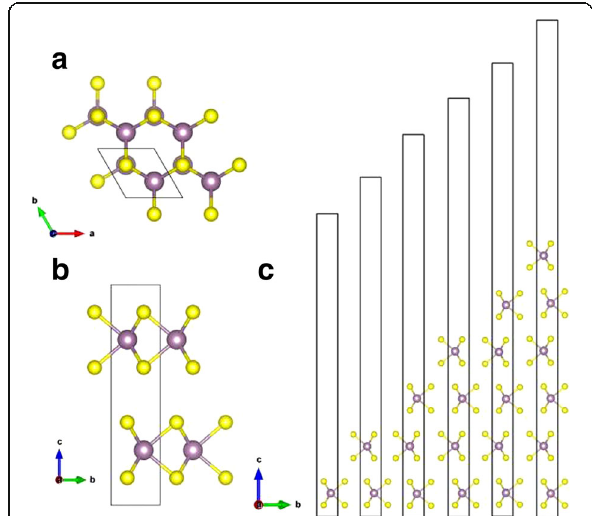
Fig. 2 a Top view and b side view of bulk-MoS 2 . c Side view of monolayer, bilayer, trilayer, as well as four-, five-, and six-layered